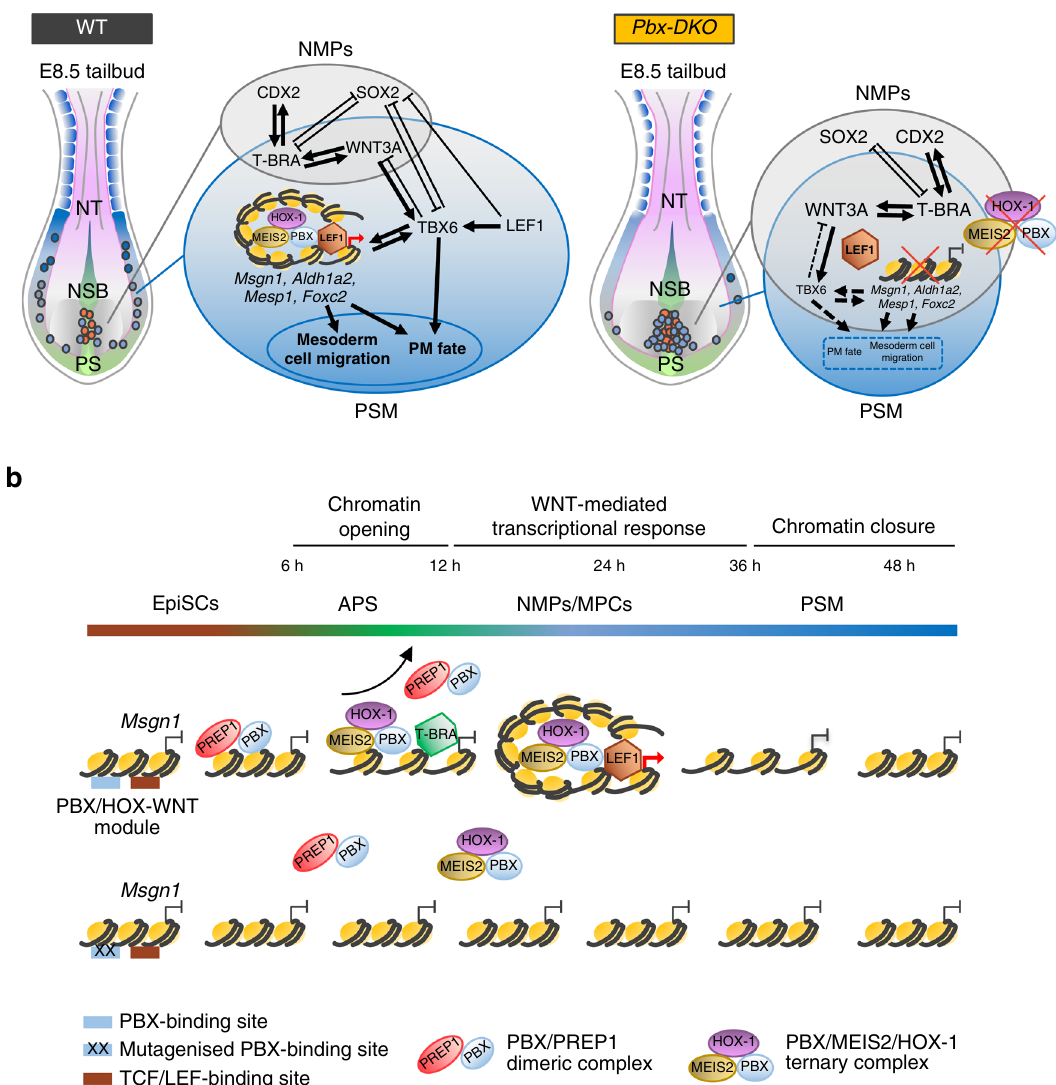
Fig. 8 TALE complexes promote WNT-mediated transcriptional response in paraxial mesoderm. a Schematics of the molecular networks at play in the E8.5 embryonic tailbud. Left: cartoon showing NMPs (red dots) transitioning to MPCs (light blue dots) and migrating to the PSM (blue) in WT embryos. GRNs governing the balance between NMP expansion in the CLE (grey) and PSM differentiation (blue) are illustrated. The TALE complexes and LEF1 bind cooperatively to the regulatory regions of PM genes, like Msgn1, Aldh1a2, Mesp1 and Foxc2 , promoting their expression. The activation of the PM programme ultimately controls migration of MPCs from the progenitor zone to the PSM and the acquisition of PM fate. Right: PBX loss (yellow) results in reduced mobility of the MPCs and accumulation of NMPs-MPCs in the progenitor zone, leading to enlarged tailbuds and reduced PSM formation. Failure of TALE complex assembly on the regulatory regions of PM genes impairs LEF1 recruitment and activation of the GRN promoting PSM formation. In contrast, the molecular circuits sustaining NMP expansion are maintained by positive feedback loops. Of note, the observed PBX-LEF1 binding to the N1 repressive element of the Sox2 regulatory region suggests that PBX and LEF1 cooperative activity could repress Sox2 expression (Fig. 5e) and NMP maintenance. Thus, PBX proteins are required for the transition of NMPs to PSM, playing essential and previously unappreciated roles in the early stages of somitogenesis. CLE caudal lateral epiblast, NSB node-streak border, PS primitive streak, PSM pre-somitic mesoderm, NT neural tube. b Model of the transcriptional activation of Msgn1. Msgn1 regulatory region becomes accessible at 12 h following the collaborative pioneering activity of T-BRA and the TALE complexes. Low-af fi nity PBX/PREP1 dimers are recruited fi rst and could serve as HOX-1 attractors, or assist the loading of the high-af fi nity PBX/MEIS2/HOX-1 ternary complex, whose cooperative binding displaces nucleosomes and generates the suitable chromatin context for LEF1 recruitment. Single-base substitutions at the PBX/HOX-1-binding site abrogate accessibility of both PBX/HOX-1 and LEF1-binding regions, emphasising the role of TALE complexes as modulators of chromatin accessibility on WNT-responsive